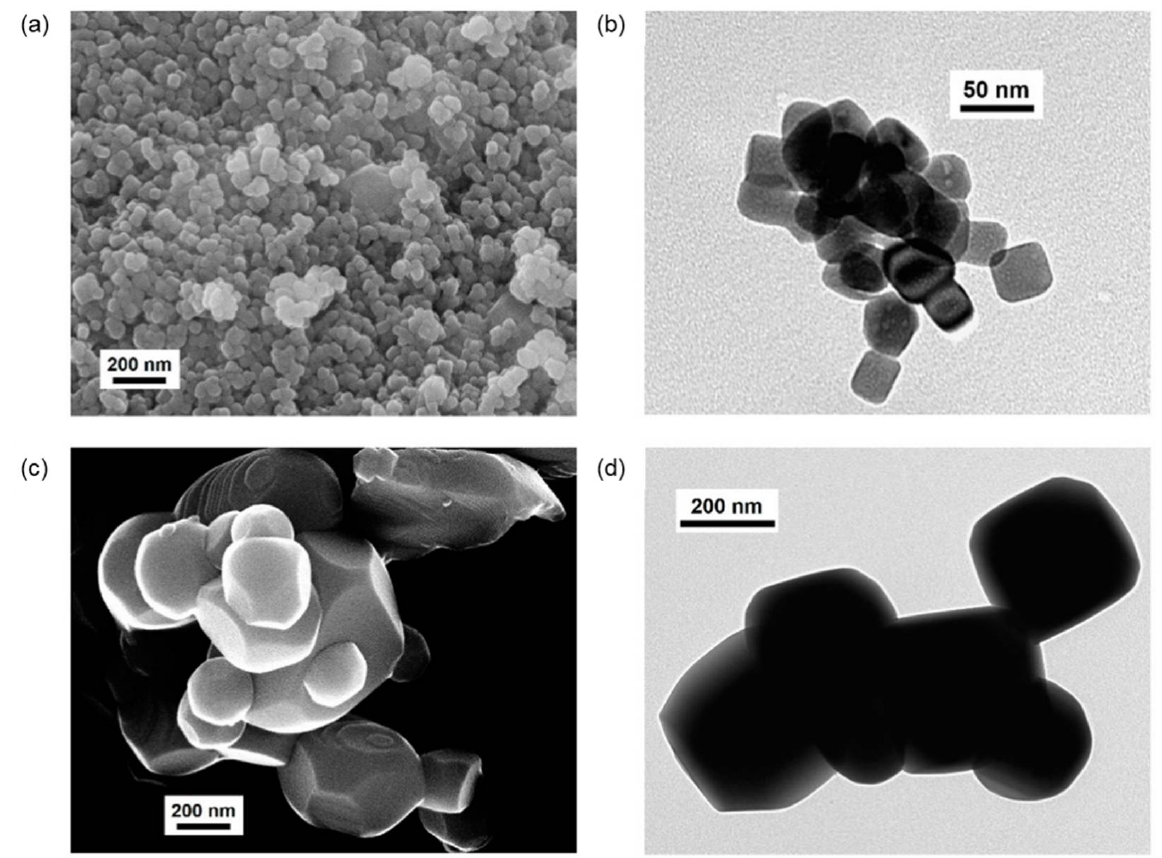
Figure 7. SEM and TEM images of STOn ( a , b ) and STOm ( c , d ).